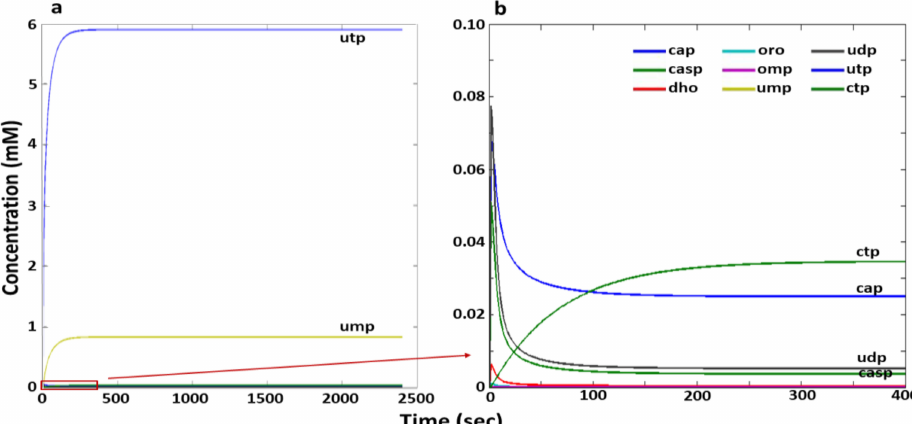
Figure 2. Simulation results of the pyrimidine biosynthesis model in the E. coli cell adapted manually to the experimental data (Table S4, column “manual,” Supplementary Text S3). The X axis is time (sec), the Y axis is the concentration of metabolites (mM). Designations: cap—carbamoyl phosphate, casp—carbamoyl aspartate, dho—dihydroorotate, oro—orotate, omp—orotidine monophosphate, ump—uridine monophosphate, udp—uridine diphosphate, utp—uridine triphosphate, ctp—cytidine triphosphate. The red rectangle in ( a ) marks the area that corresponds to ( b ). The color labels of the metabolite concentration curves in Figures ( a , b ) are the